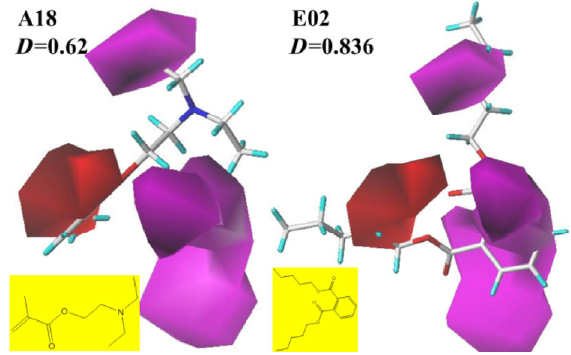
Fig. 6 CoMSIA contour diagram for hydrogen-bond field with embedded A18 and E02 as reference. Magenta and red regions show where hydrogen-bond acceptor is favored and disfavored,